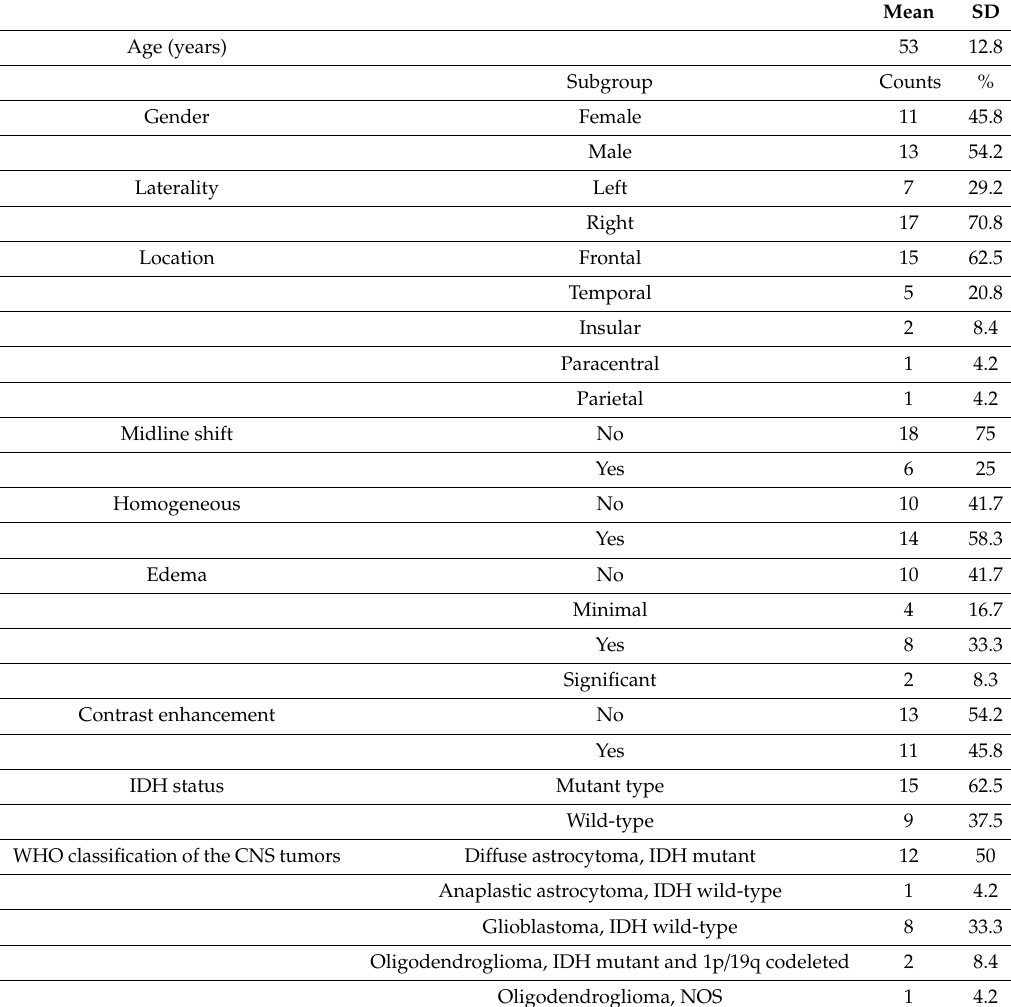
Table 1. Basic characteristics of our patient sample ( n =